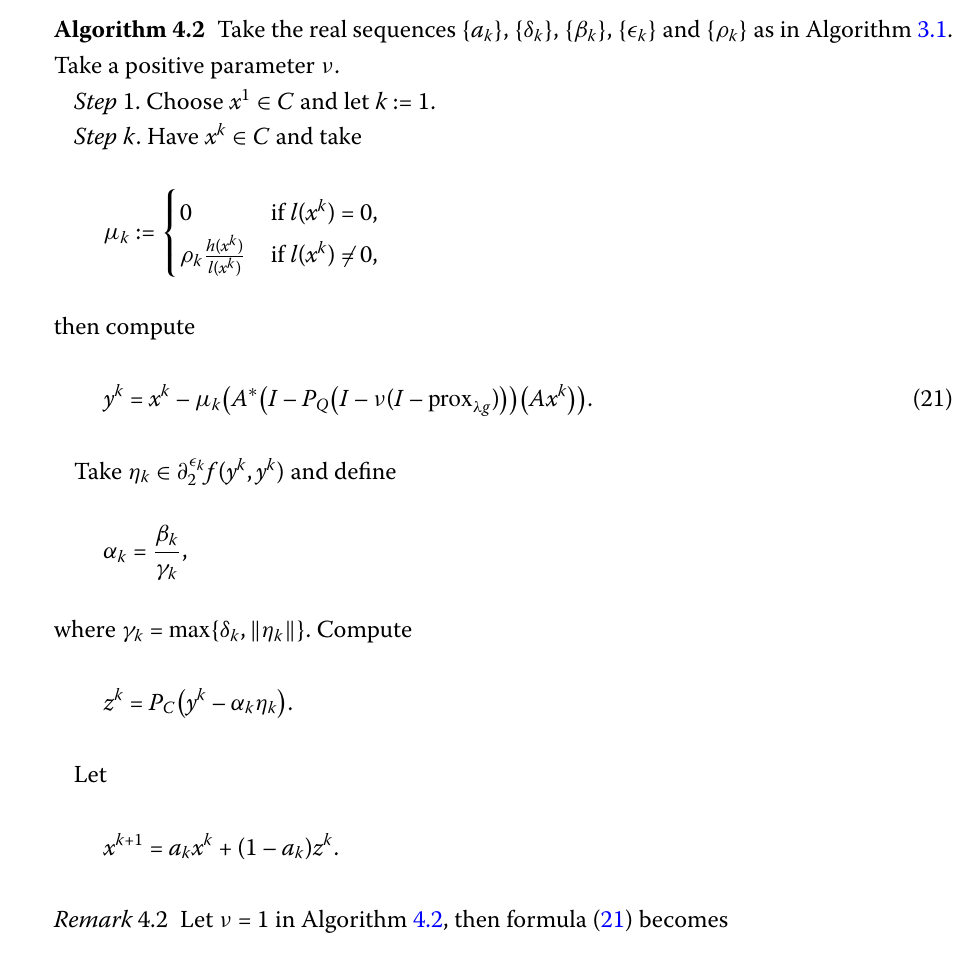
Algorithm 4.2 Take the real sequences { a k } , { δ k } , { β k } , { (cid:4) k } and { ρ k } as in Algorithm 3.1. Take a positive parameter ν